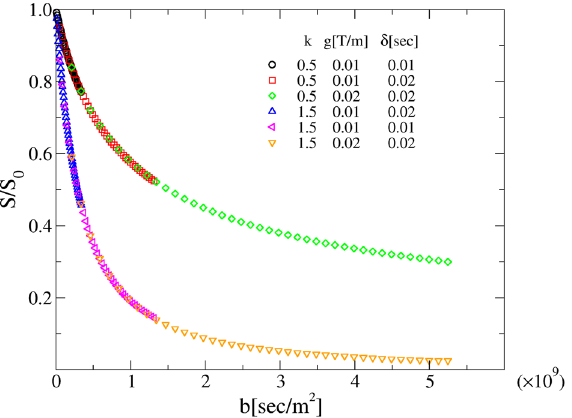
Figure 6. SS assessment criterion. Behavior of the synthetic rescaled DW-NMR signals as a function of the (γ g δ) 2 (� δ/ 3 ) for SS systems with a Gamma distribution P ( D parameter b = −